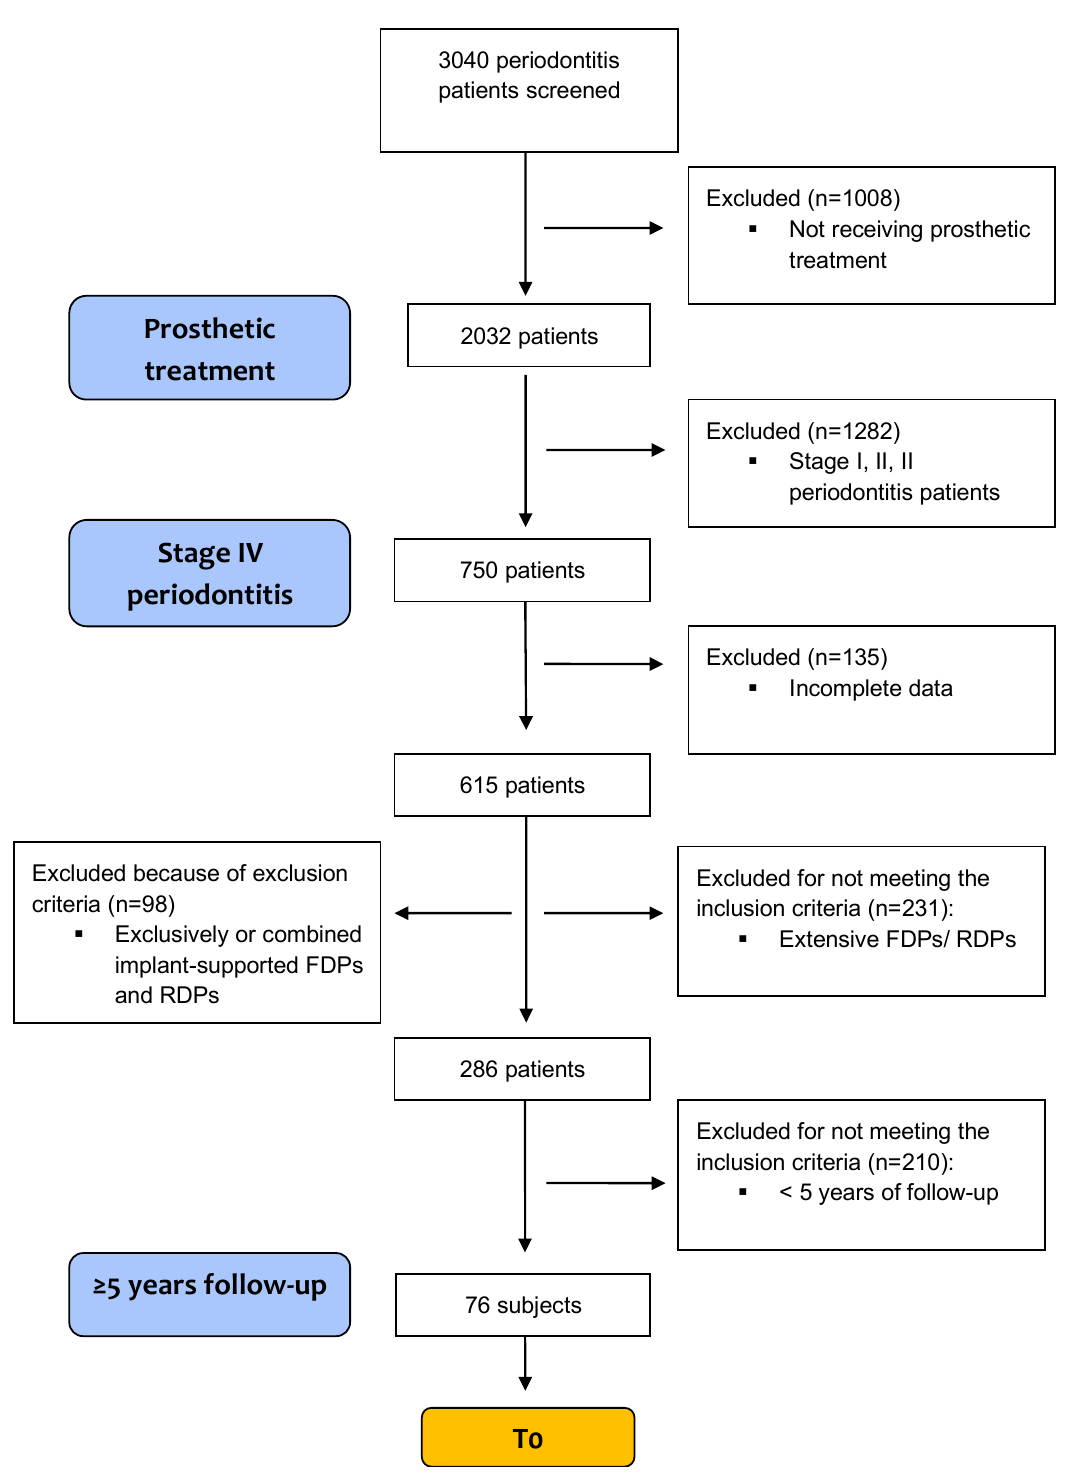
Figure 1. Study flow diagram based on inclusion and exclusion criteria.